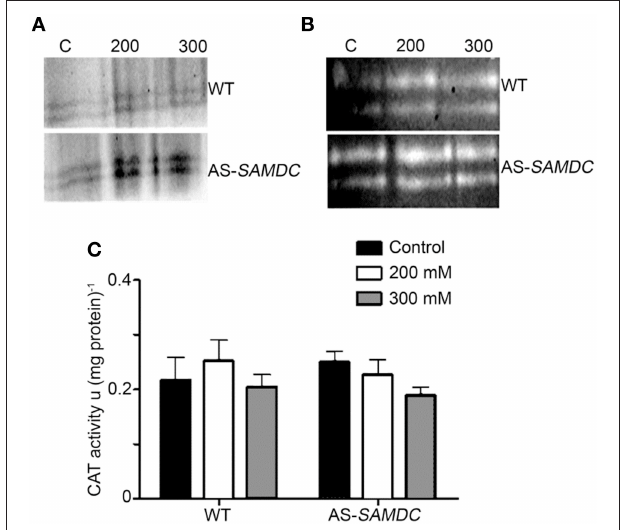
FIGURE 7 | Activities of NADPH-oxidase, SOD and CAT in WT and AS- SAMDC plants under control and 24 h post-treatment with 200 or 300mM NaCl. (A) In-gel activity assay of NADPH-oxidase. Images are from a single representative experiment replicated three times. C, control. (B) In-gel activity assay of cytoplasmic (CuZn-SOD; upper band) or mitochondrial SOD (Mn-SOD; lower band). Images are from a single representative experiment replicated three times. C, control. (C) Specific activity of CAT. Data are means ± SD of three biological